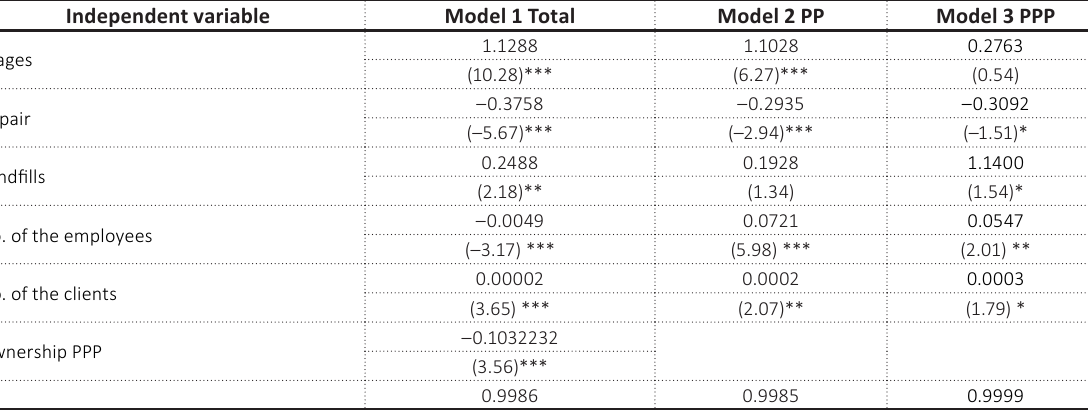
Table 4. Empirical